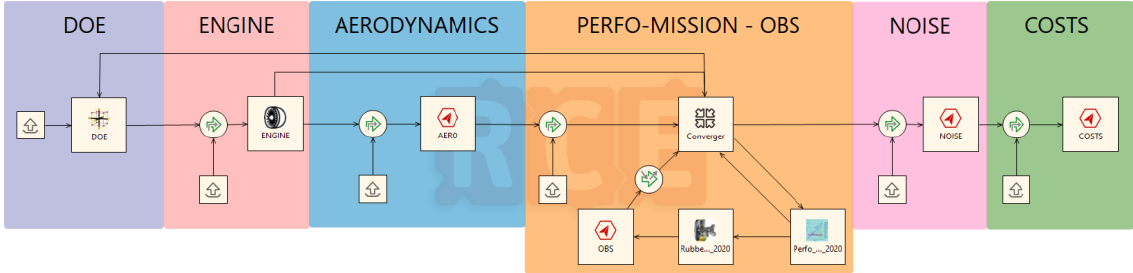
Figure 8. Executable AGILE 4.0 workflow in an RCE environment, as an example of a converged